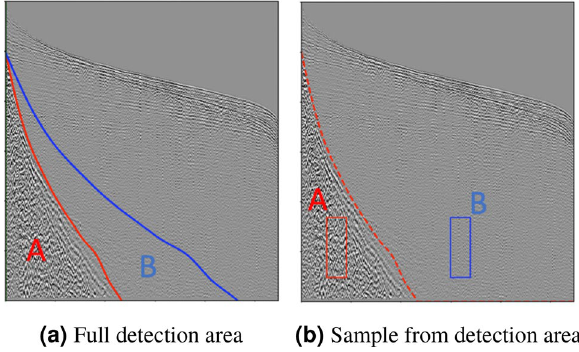
Figure 4. Gather loci for computing filtering metrics: region A corresponds to ground roll affected regions and region B corresponds to noise-free regions. ( a ) The detected area and the corresponding mirrored signal area, and ( b ) rectangular samples from ground roll-affected and noise-free areas. Image from Oliveira et al. 28